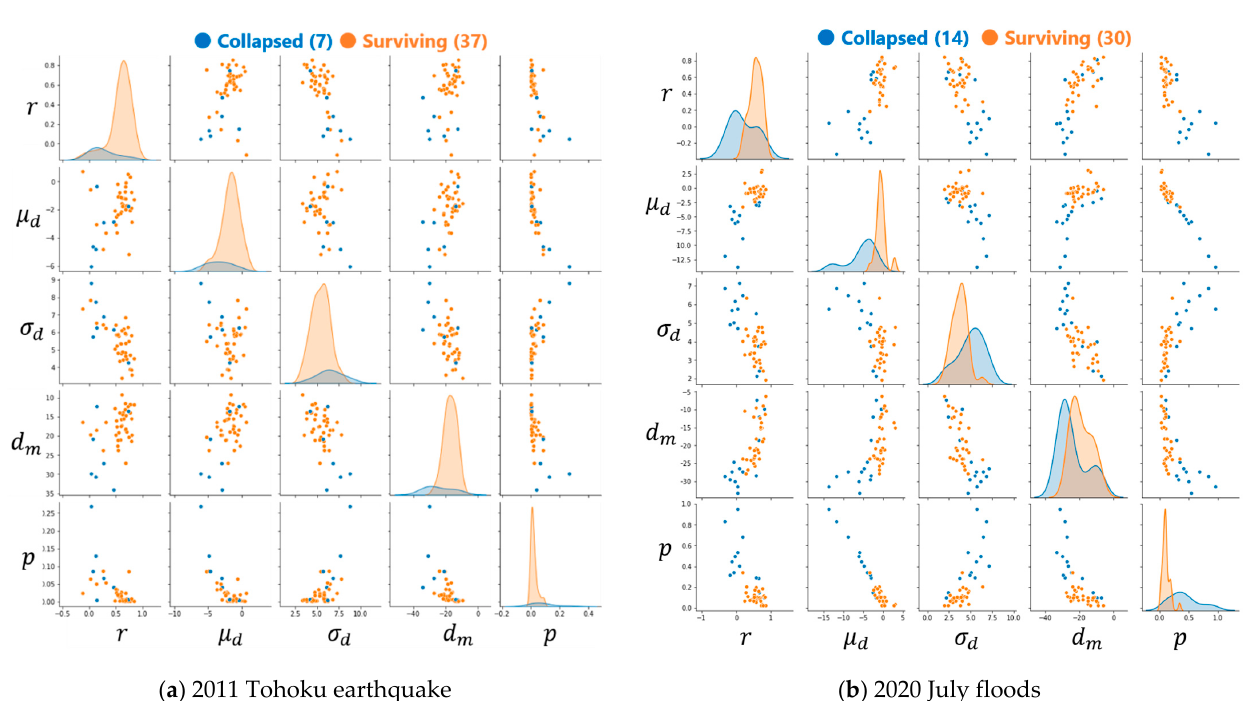
Figure 5. Scatter plots of the five adopted change features of the target bridges affected in the 2011 Tohoku earthquake ( a ) and the 2020 July floods ( b ).